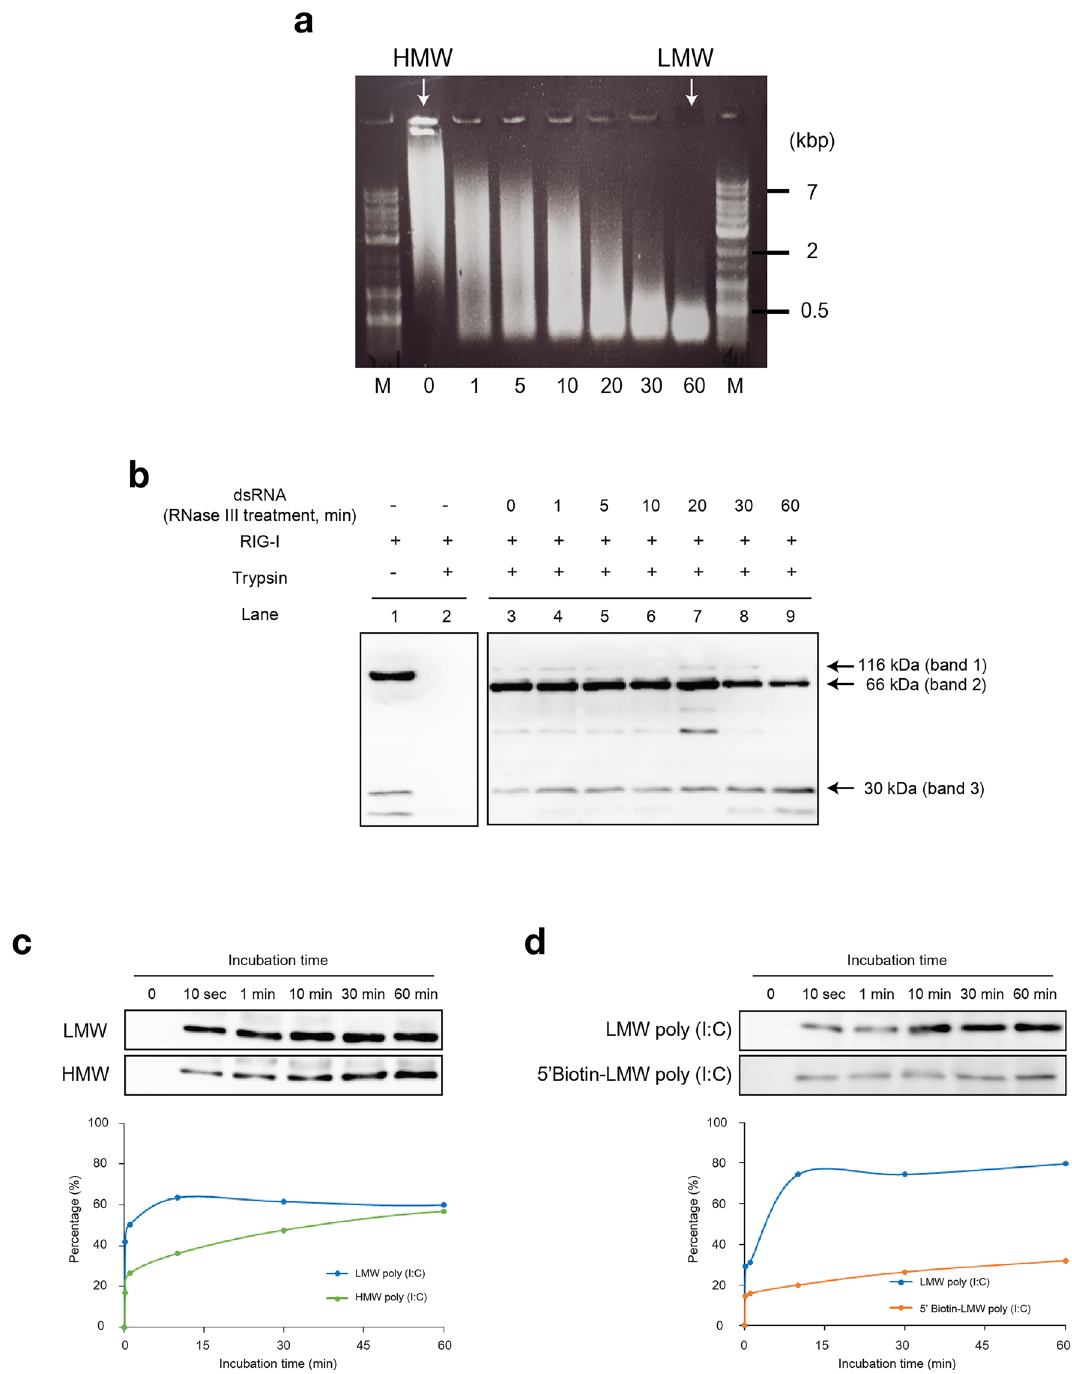
Figure 1. Binding of RIG-I with different lengths of poly (I:C). ( a ) Generation of different sizes of poly (I:C) by RNase III digestion. Commercial poly (I:C) (designated as high molecular weight, HMW) was digested for 0, 1, 5, 10, 20, 30, and 60 min with RNase III to generate different sizes of poly (I:C). The product obtained after 60 min of digestion was used as low molecular weight (LMW) poly (I:C). M: DNA marker. ( b ) Trypsin digestion of RIG-I/poly (I:C) complex. Purified recombinant RIG-I (insect cell) and different sizes of poly (I:C) generated in ( a ) were mixed at 37 °C for 30 min. The reaction mixture was digested with trypsin at 37 °C for 5 min. The reaction mixtures were subjected to SDS-PAGE and immunoblotting with anti-RIG-I (METHODS) as the probe. Undigested RIG-I and RIG-I digested without incubation with poly (I:C) are shown in lanes 1 and 2, respectively. The uncropped original blots are shown in Supplementary Fig. S7a. ( c ) Binding kinetics between RIG-I and poly (I:C) were analyzed. HMW or LMW poly (I:C) was immobilized on magnetic beads through anti-dsRNA antibody. Beads were incubated with recombinant RIG-I for indicated times. RIG-I bound to poly (I:C) was recovered and analyzed by immunoblotting with anti-Flag (top) and band intensity was quantified (bottom). The uncropped original blot is shown in Supplementary Fig. S7b. ( d ) The effect of end modification of poly (I:C) on association with RIG-I. LMW poly (I:C) and biotinylated LMW poly (I:C) (METHODS, 86.6% biotinylated) were subjected to RIG-I binding assay as in (c). The uncropped original blots are shown in Supplementary Fig.